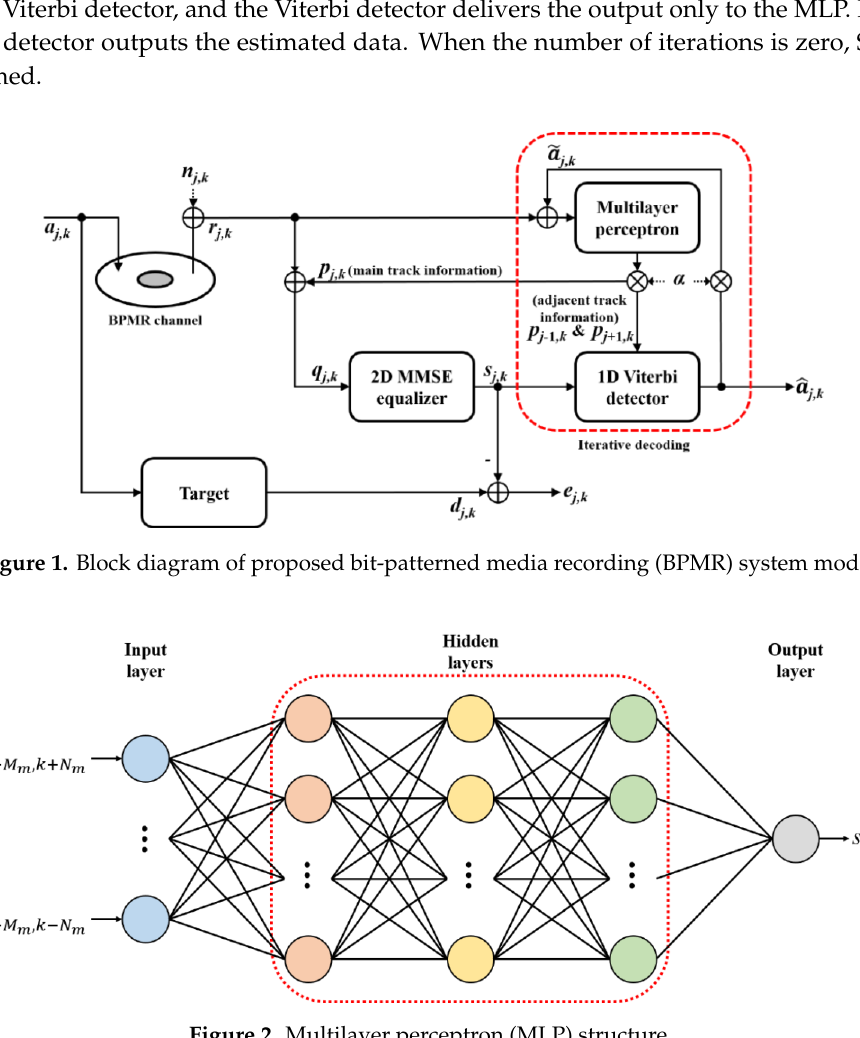
Figure 2. Multilayer perceptron (MLP)